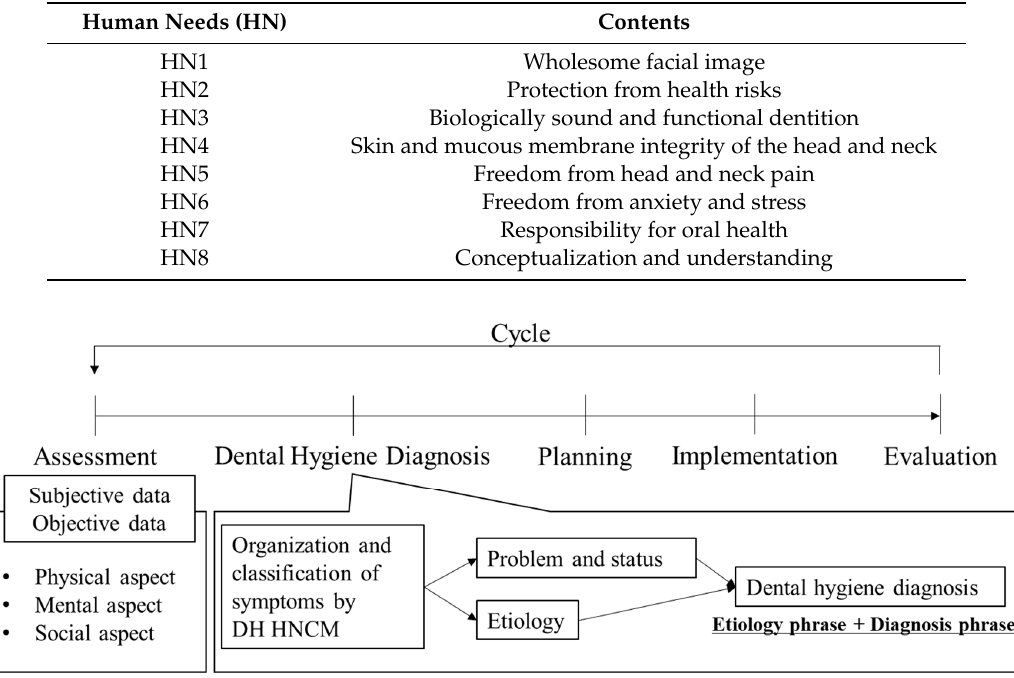
Table 1. Dental Hygiene Human Needs Conceptual Model.